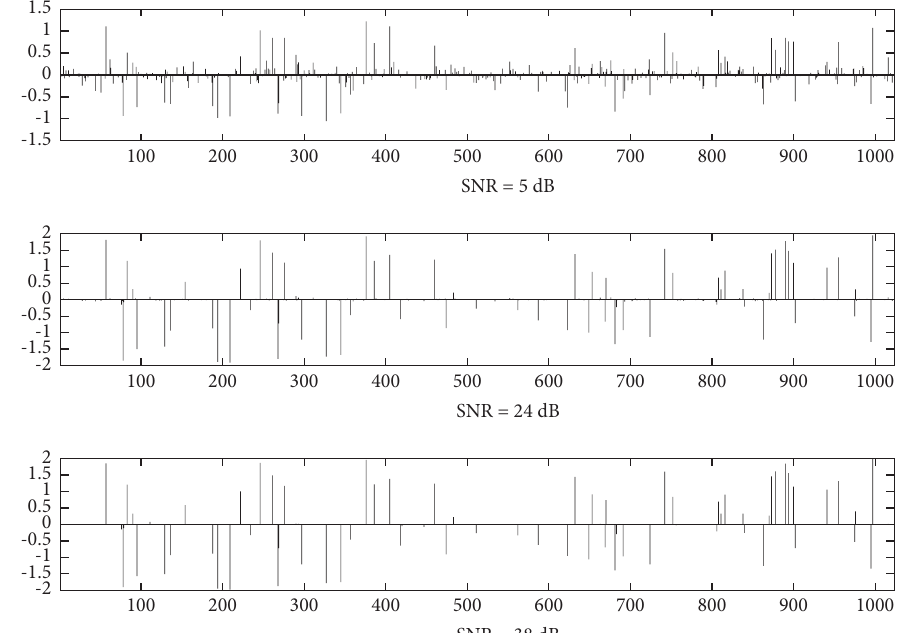
Figure 13: Recovering signals based on the SNR quality for the degraded signal with operator A